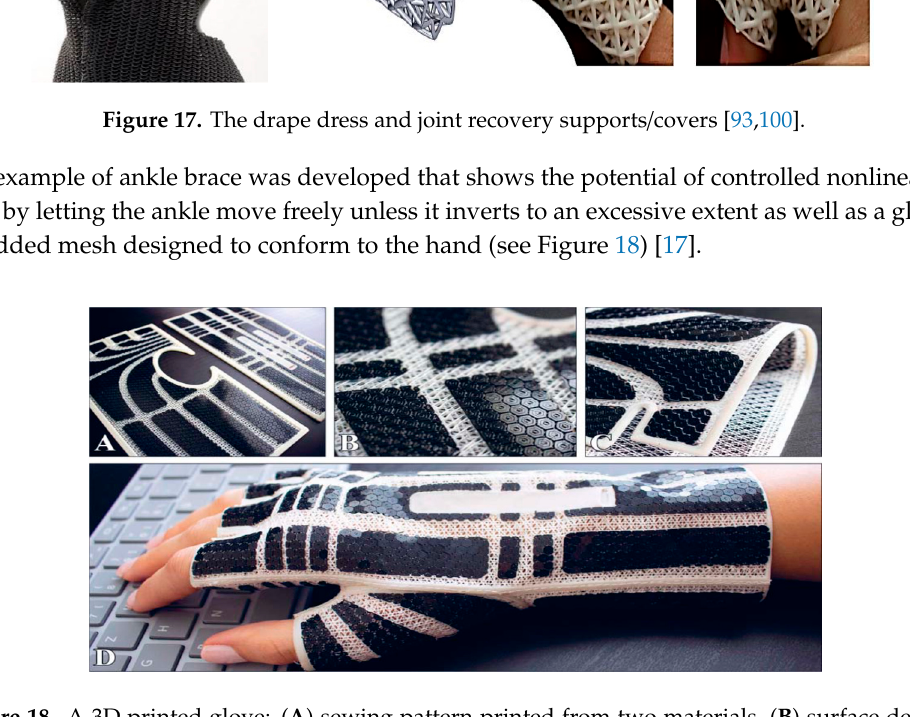
Figure 17. The drape dress and joint recovery supports/covers [93,100].